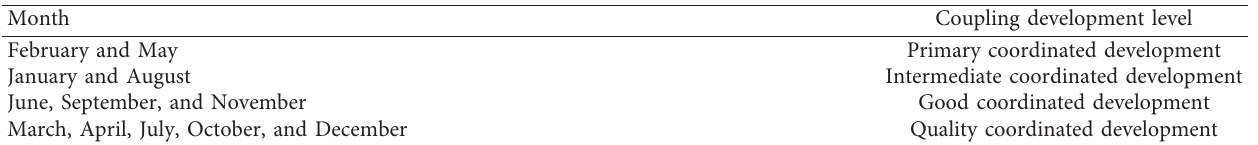
Table 9: Levels of the coupling development degree of the ternary system in each month of